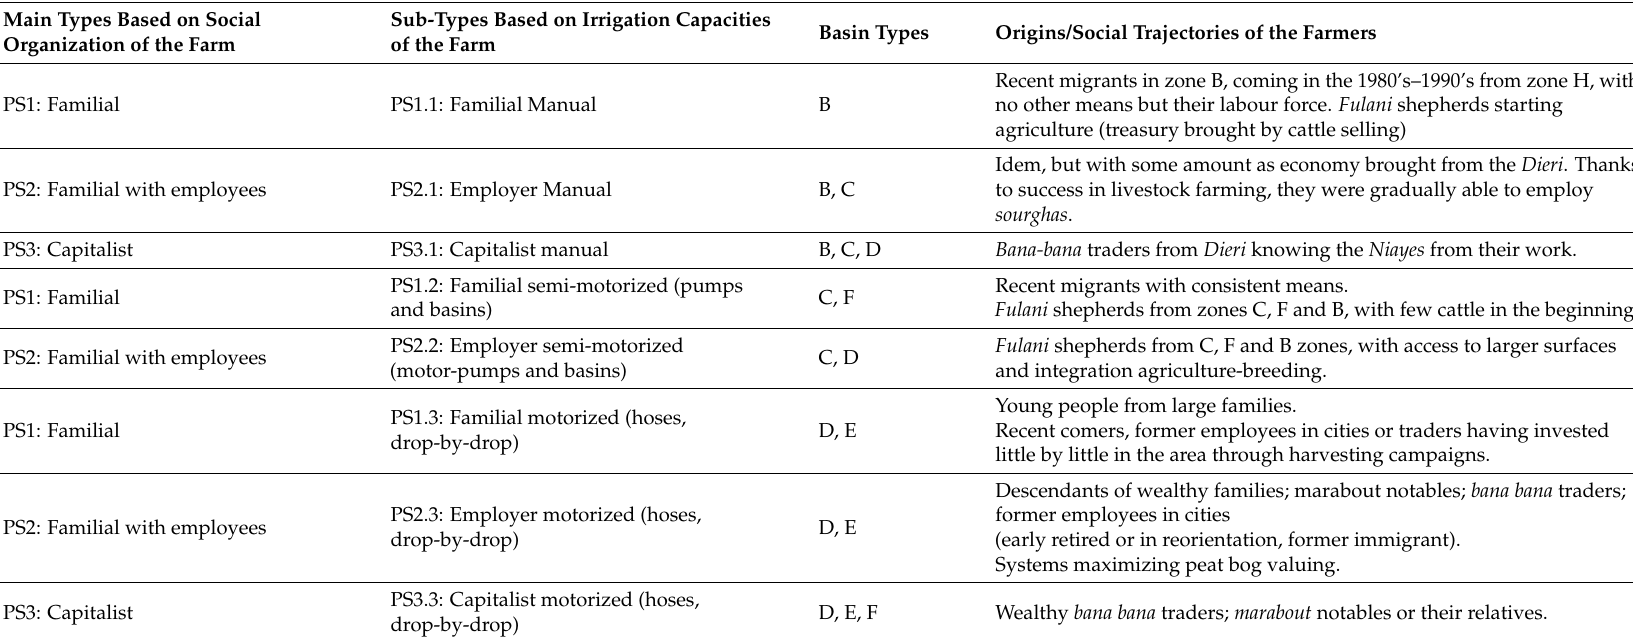
Table 4. Niayes agricultural ventures’ historical trajectories and current production systems